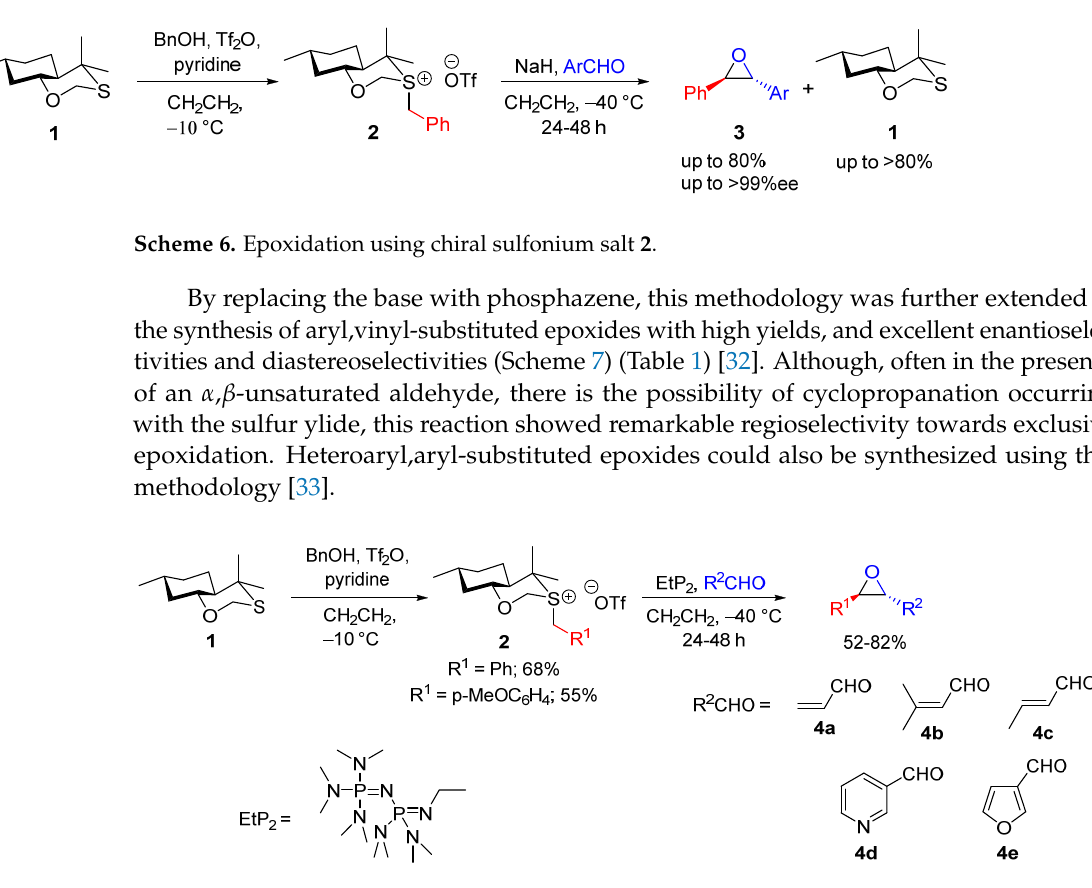
Table 1. Solladié-Cavallo asymmetric synthesis of epoxides using sulfonium salt 2 (Scheme 7). Entry R 1 (Ylide) R 2